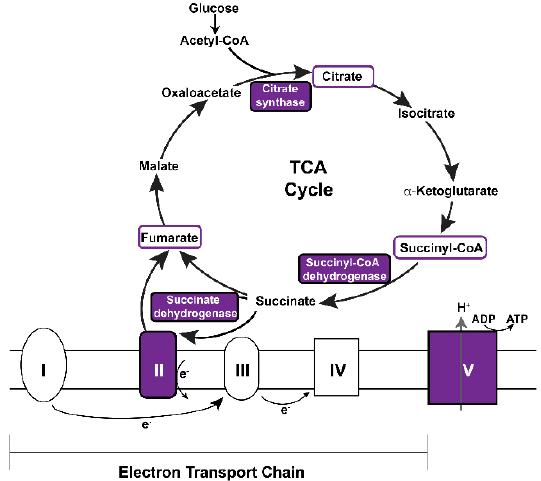
Figure 6. Vitamin A deficiency decreases the abundances of key components of the mitochondrial TCA cycle and electron transport chain. Purple color indicates significantly decreased proteins or subunits in vitamin A-deficient eyes. For details, see text.